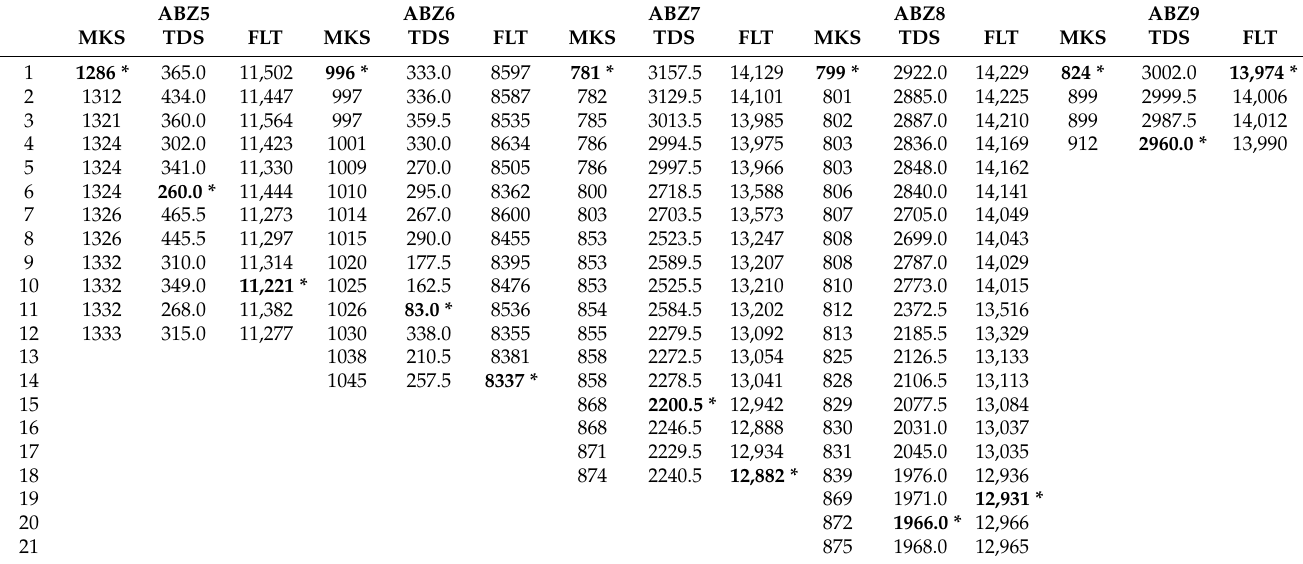
Table A4. Non-dominated solutions obtained by SS/LS for the JSSP instances proposed by